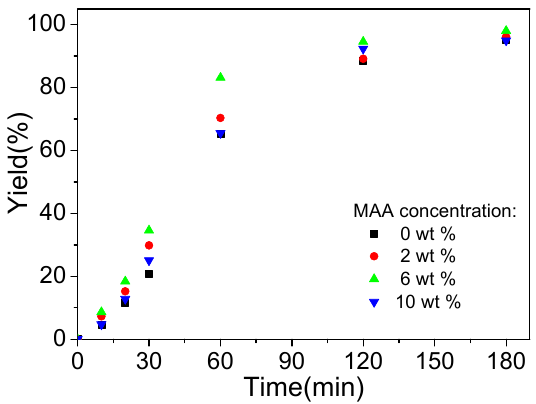
Figure 2. Plots of particle yield versus ultra violet (UV) irradiation time of polymeric microspheres prepared by photoinitiated RAFT dispersion polymerization with different concentrations of MAA.